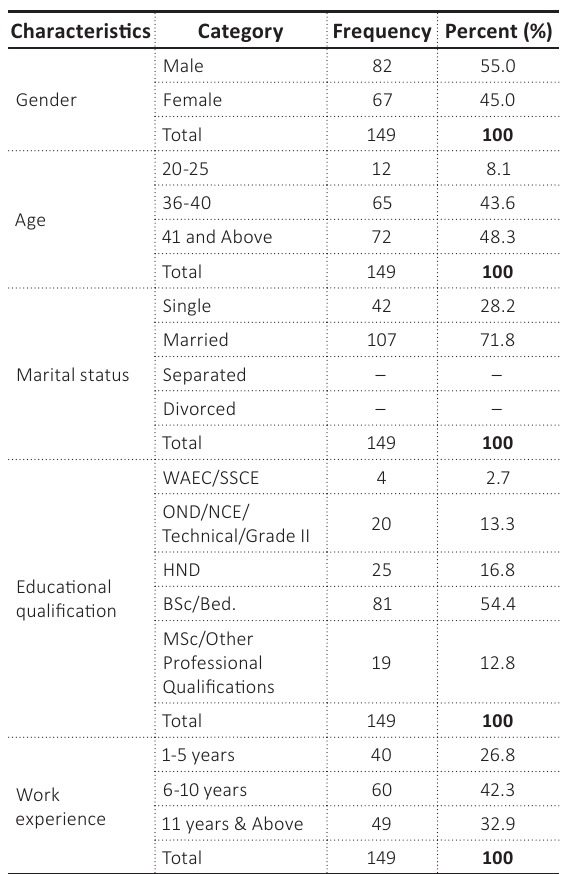
Source: Study’s fieldwork.